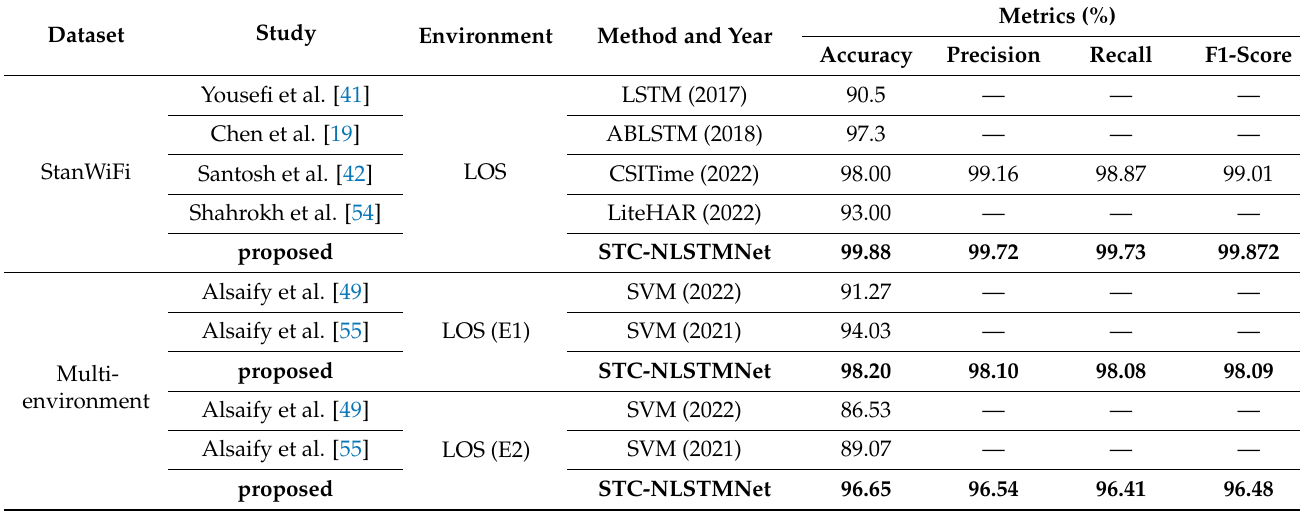
Table 7. Comparison between the proposed system and other existing